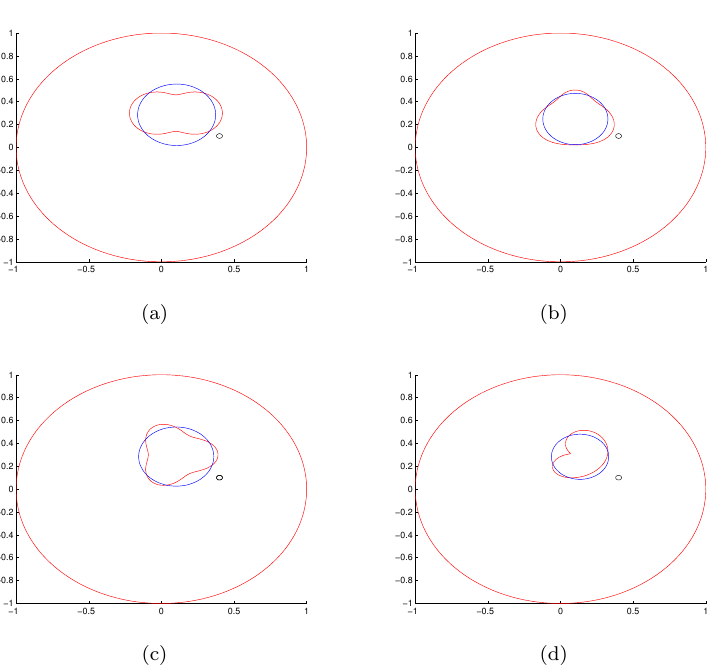
Figure 4. (a) Peanut; (b) peach; (c) pear; (d) bean. Apply TRA to determine the location O and the size ρ of the coefficient along with exact solution (red), initial guess (black) and recovered solution (blue), respectively for Example